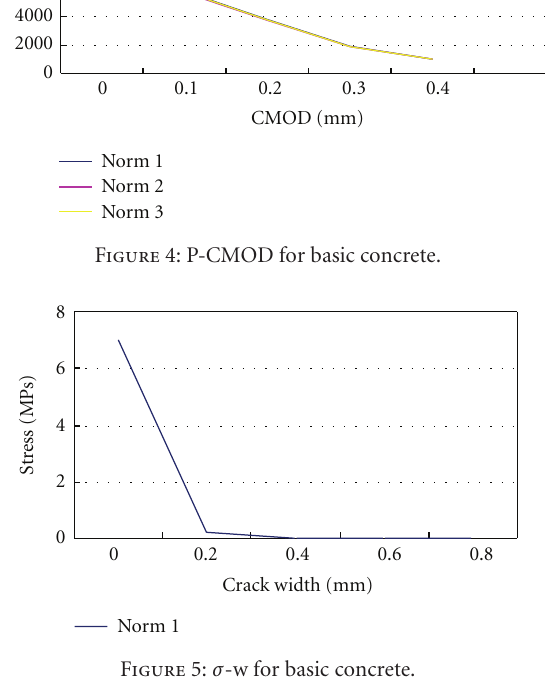
Figure 2: C120 high-performance concrete fracture parameter test.